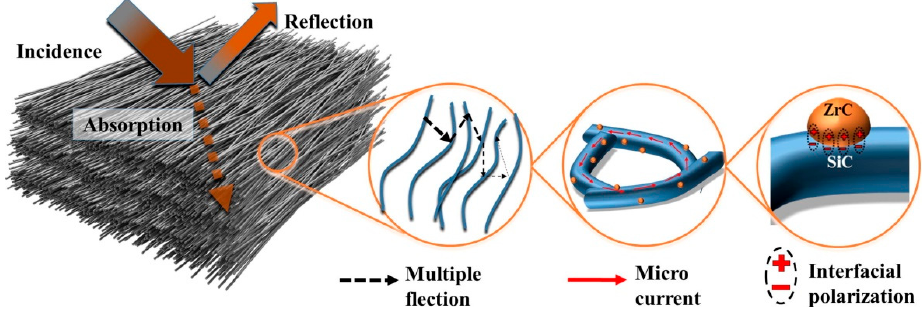
Figure 7. Schematic of EM wave shielding for ZrC/SiC nanofiber mats. From [85], copyright (2021), with permission from Elsevier.